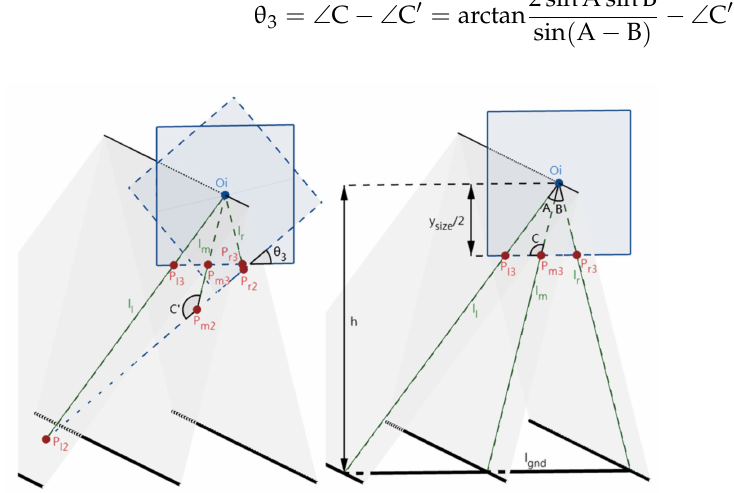
Figure 8. The imaging differences before and after step